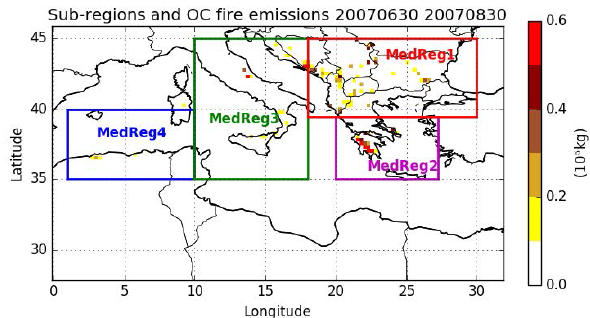
Figure 1. Map of the nested domain over the Mediterranean area with a spatial resolution of 0 . 25 ◦ × 0 . 25 ◦ . The total organic carbon emissions (kg(gridcell) − 1 ) from fires during the summer of 2007 are presented. The sub-regions used in this study are also indicated in colored boxes: MedReg1 (Balkans + eastern Europe), MedReg2 (Greece), MedReg3 (Italy) and MedReg4 (Algeria).